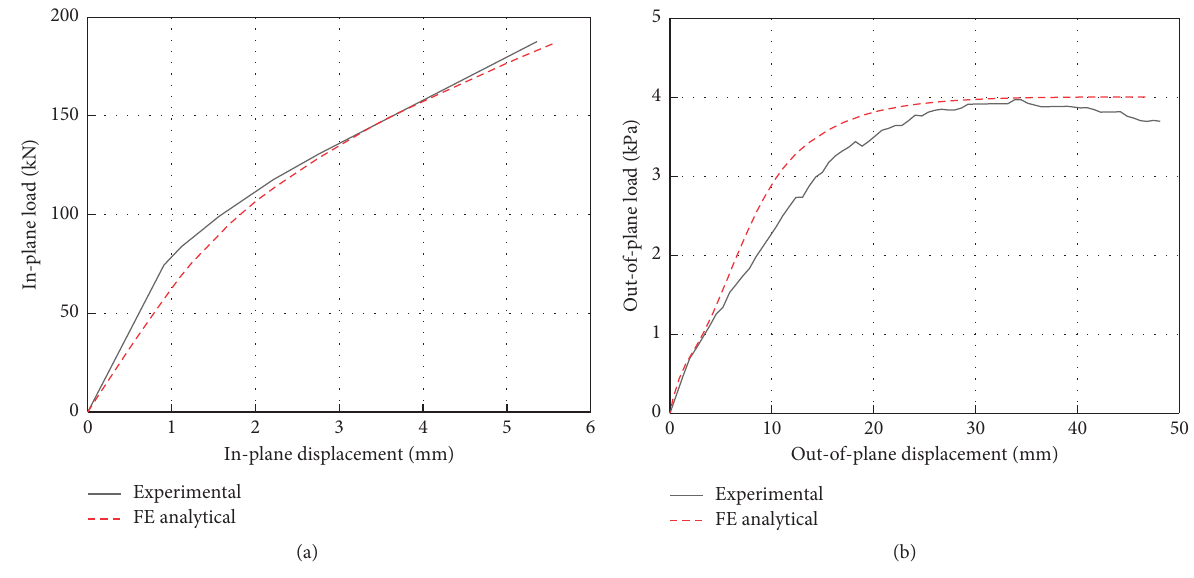
Figure 4: Load-displacement curves in (a) IP and (b) OOP directions. Table 2: Comparison of numerical and experimental